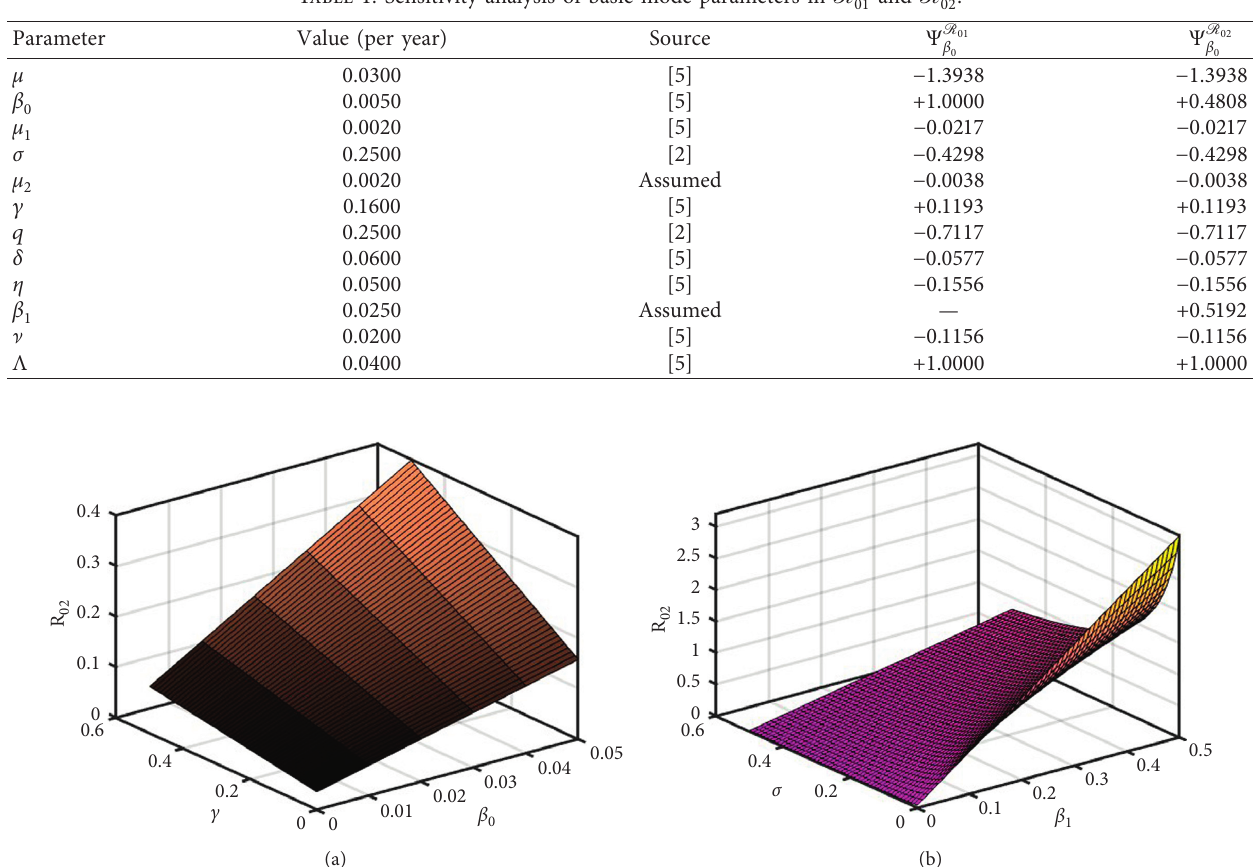
versus c and β 02